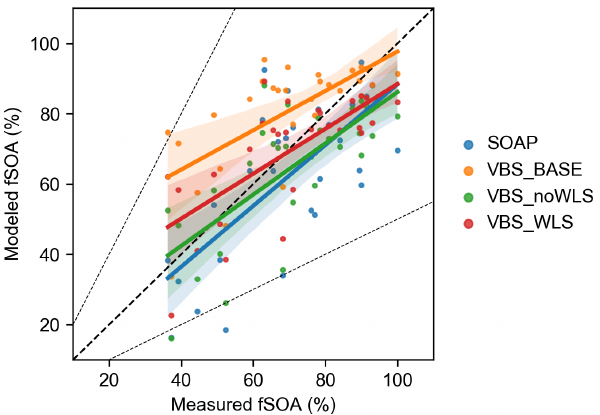
Figure 9. Comparison between modeled and measured fSOA from the literature over the year (see data and sources in Table S2). The shading indicates the confidence intervals of the regression